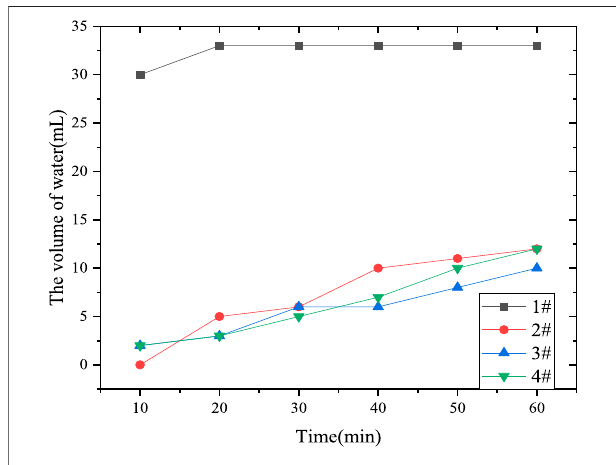
FIGURE 5 | Stability performance of heavy oil emulsion.